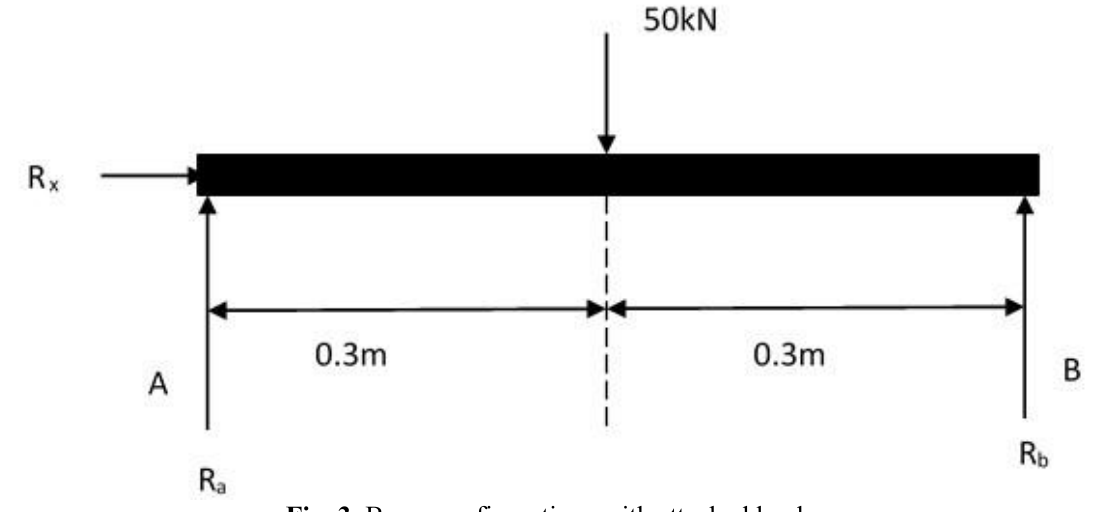
Fig. 3. Beam configurations with attached